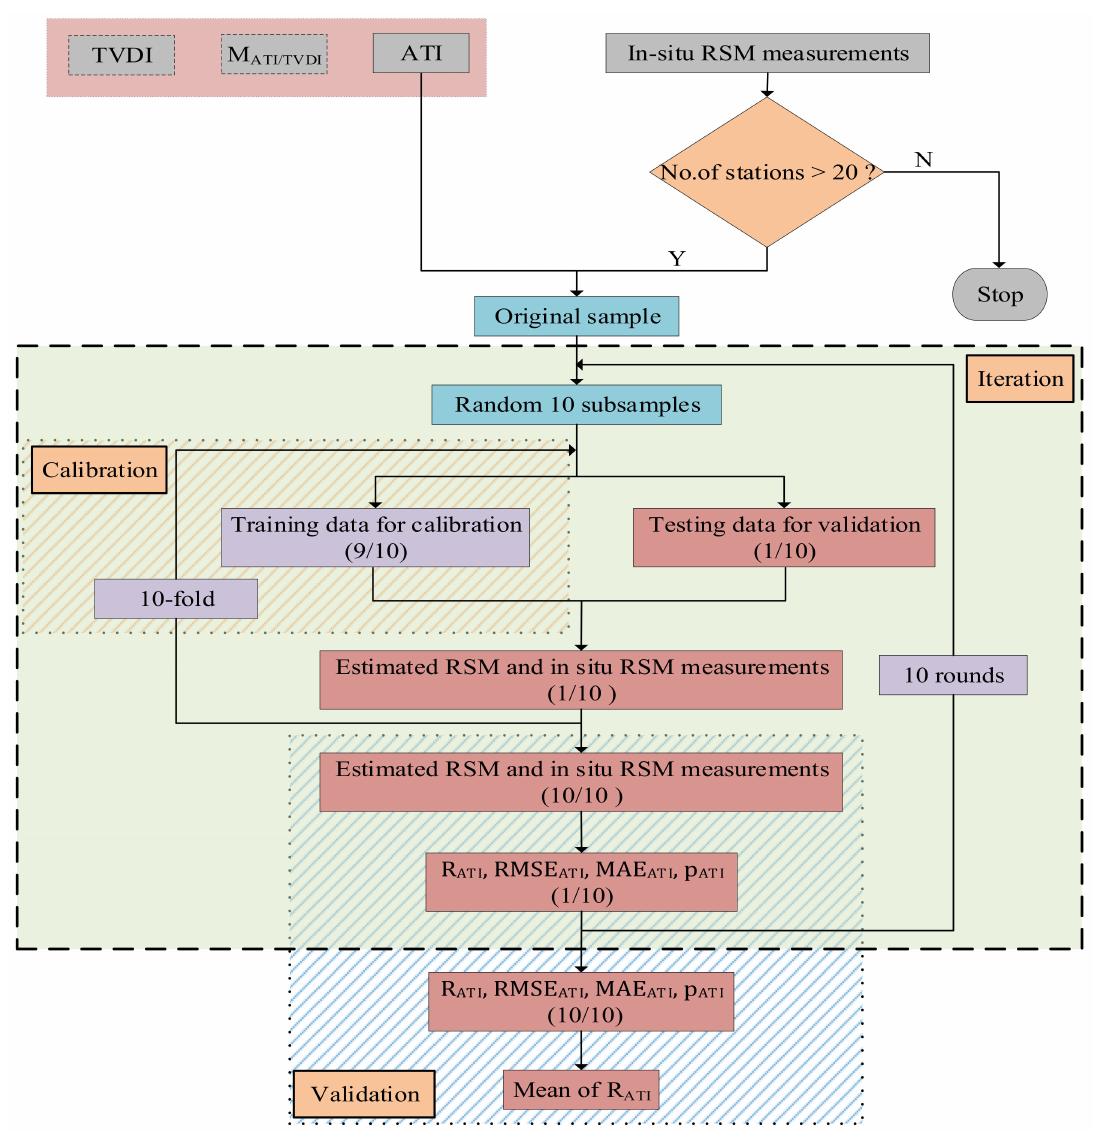
Figure 5. The flowchart of detailed calibration and validation procedures using 10 rounds of 10-fold